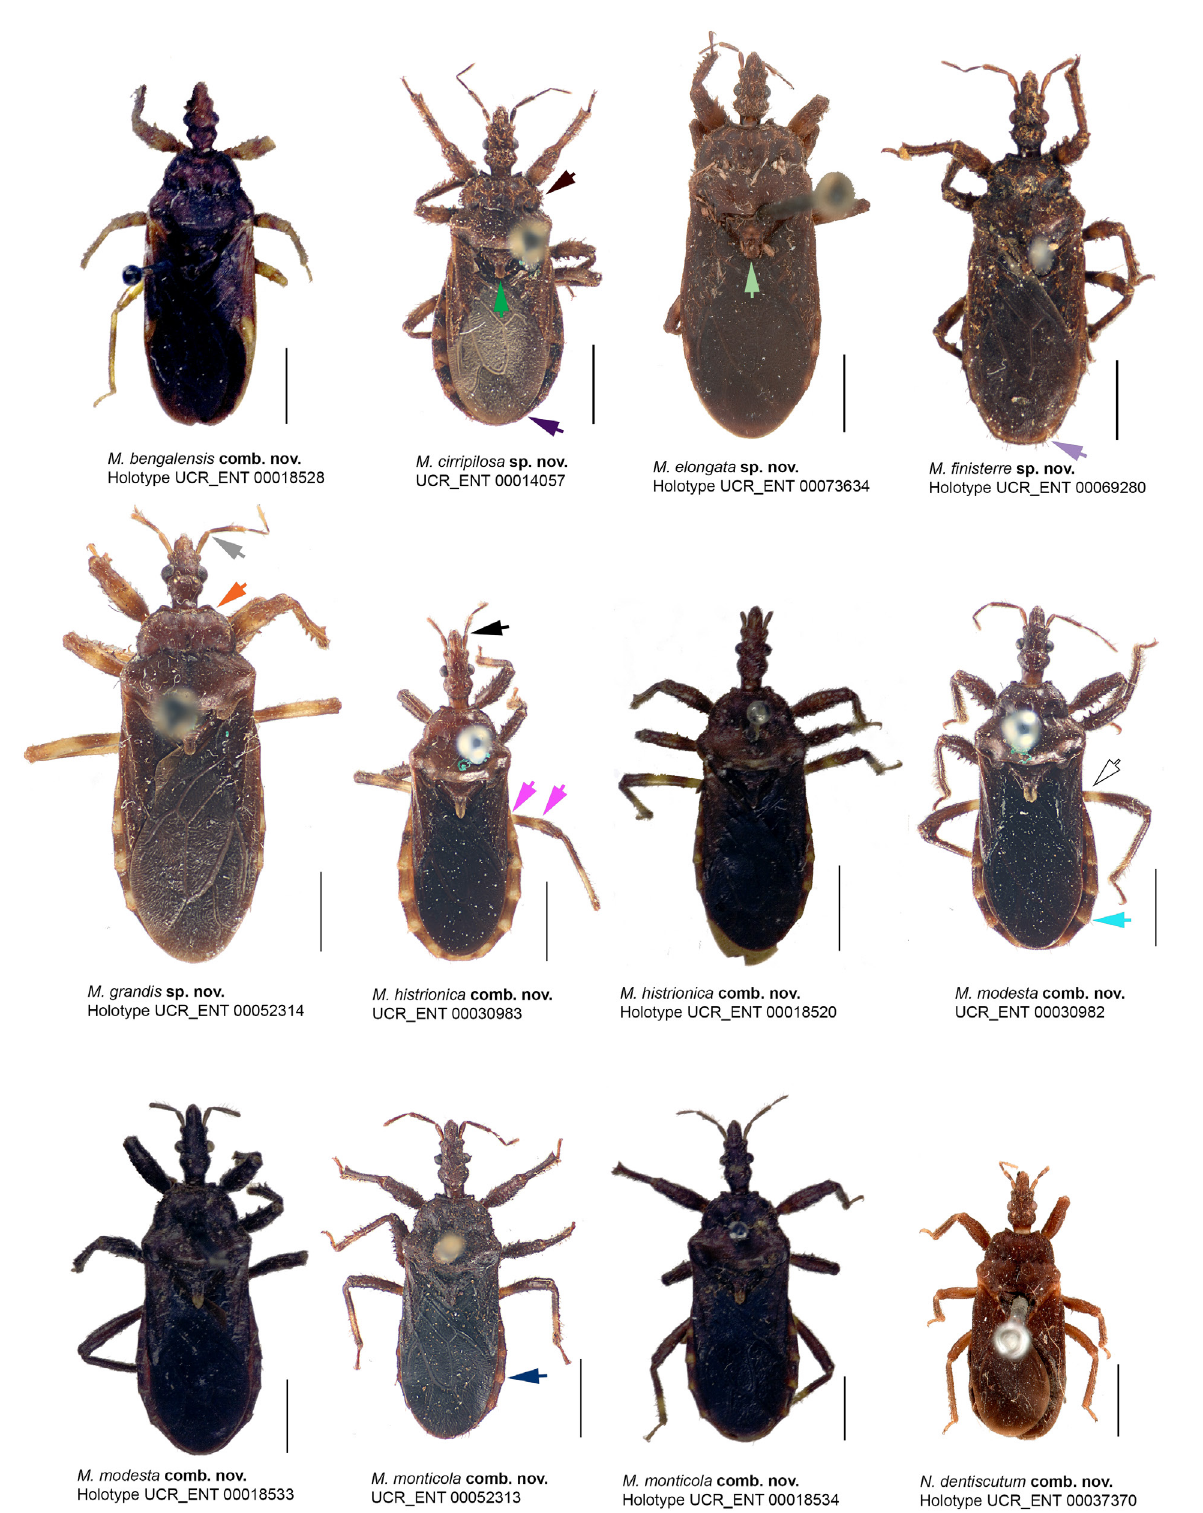
Fig. 10. Dorsal habitus images for species of Macrophysoderes gen. nov. and Nanophysoderes gen. nov. For an explanation of the colored arrows, see key on page 37. Scale bars = 2